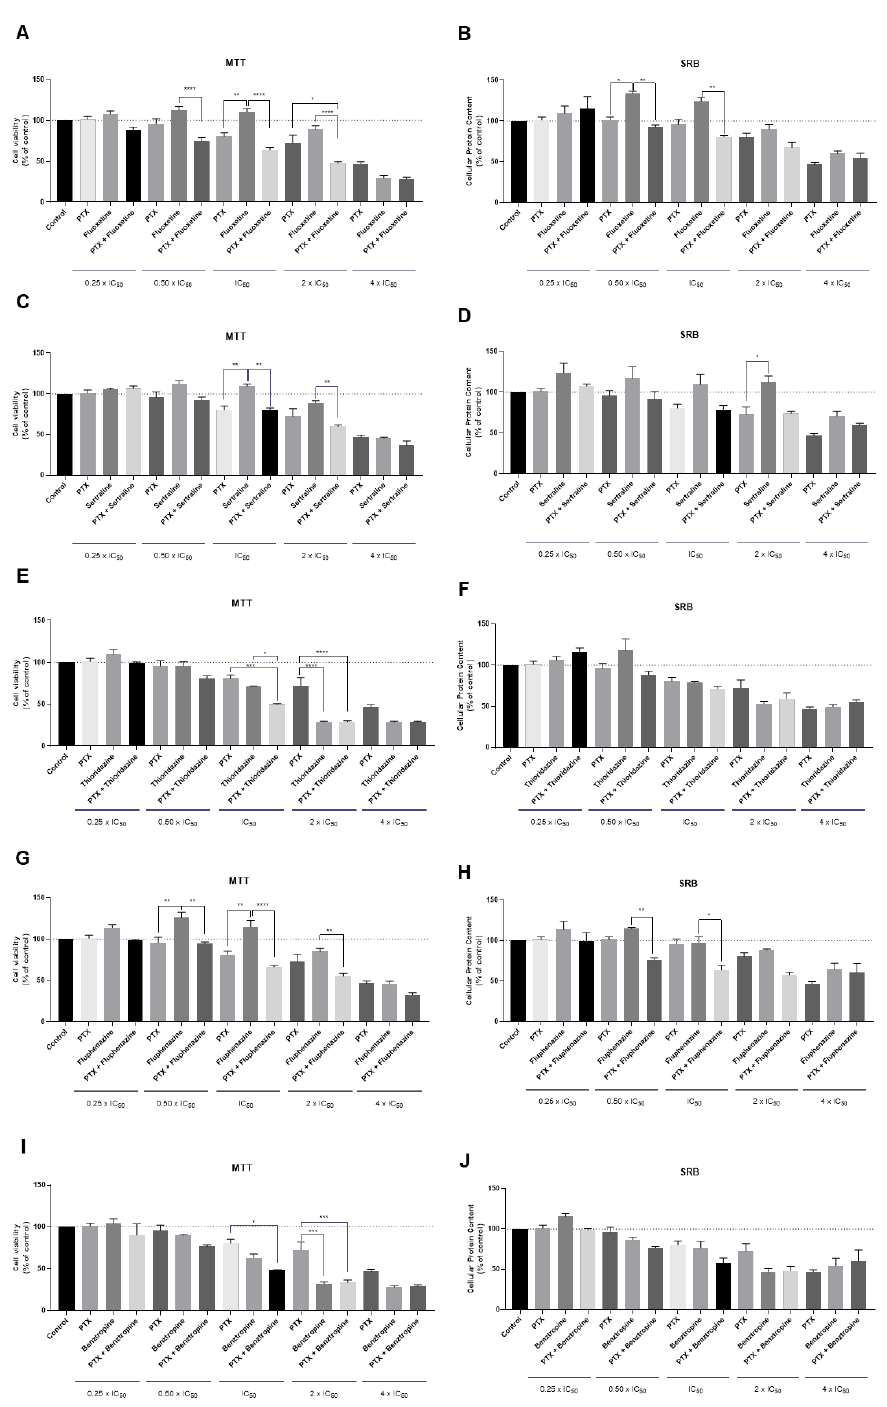
Figure 15. Growth inhibition of MCF-7 after 48 h of combination therapy with PTX, by MTT ( left ) and SRB assays ( right ). Cells were exposed to concentrations of each drug of 0.25, 0.5, 1, 2 and 4 times their IC 50 and the cell viability was evaluated by MTT and SRB assays. The drugs in combination were co-administered at the same time. ( A ) The effect of PTX plus fluoxetine on cell viability and ( B ) cell protein synthesis. ( C ) The effect of PTX plus sertraline on cell viability and ( D ) cell protein synthesis. ( E ) The effect of PTX plus thioridazine on cell viability and ( F ) cell protein synthesis. ( G ) The effect of PTX plus fluphenazine on cell viability and ( H ) cell protein synthesis. ( I ) The effect of PTX plus benztropine on cell viability and ( J ) cell protein synthesis. Values are expressed in percentage of control and represent means ± SEM. Each experiment was done three times independently ( n = 3); * statistically significant vs. control at p < 0.05. ** statistically significant vs. control at p < 0.01. *** statistically significant vs. control at p < 0.001. **** statistically significant vs. control at p <